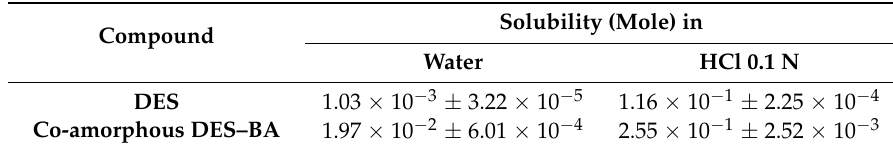
Table 1. Solubilities data of pure crystalline desloratadine (DES) and co-amorphous DES–BA systems in water and 0.1 N HCl at 37 °C.